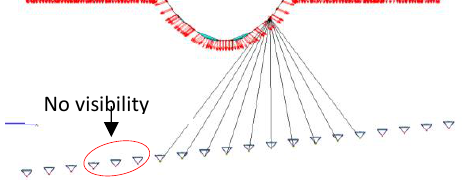
Figure 2. Visibility by using the triangular surface normal